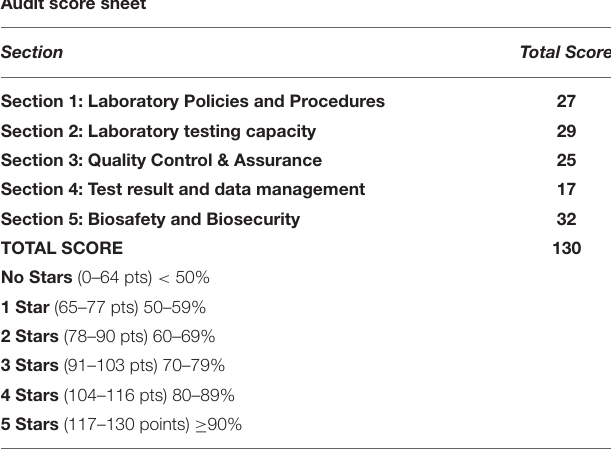
TABLE 1 | COVID-19 testing laboratory testing and certification program score card and the 5 star graduated scale used to audit laboratories in the Africa region,